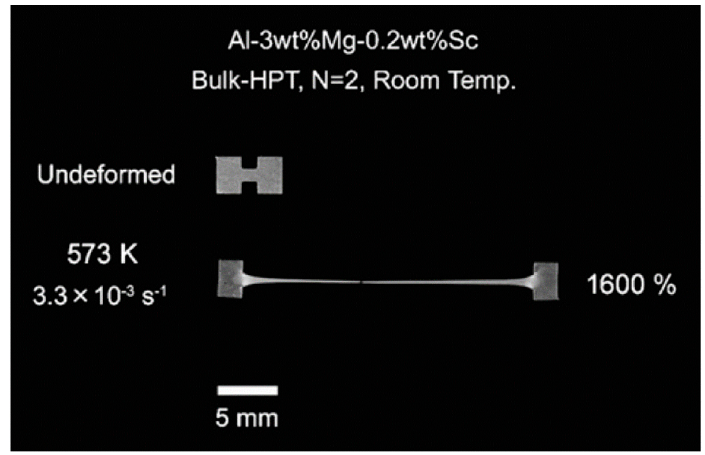
Figure 10. An example of superplasticity in an Al–Mg–Sc alloy processed by HPT [45].